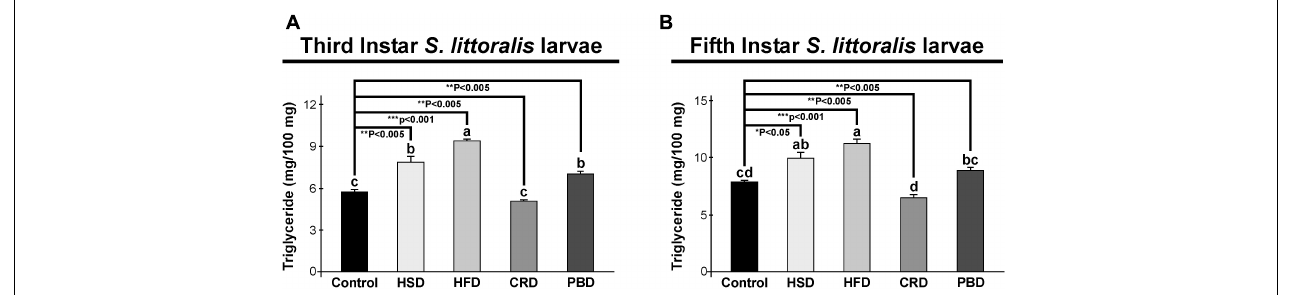
FIGURE 2 | Effects of different diet treatments on the triglyceride levels of Spodoptera littoralis . Triglyceride levels at third (A) and fifth instar (B) larval bodies are shown as mg in 100 mg body weight. Statistical significances in the entire sample set were determined by using one-way ANOVA, followed by a Tukey HSD test (groups associated with different letters are significantly different among each other, p < 0.05). A t -test was used for binomial comparisons (diet treatment vs control) (* p < 0.05, ** p < 0.005, *** p < 0.001 indicate the statistical differences between the particular diet and the control). Values are expressed as means ± standard error. Control, Regular artificial bean diet; HSD, High sugar diet; HFD, High fat diet; CRD, Calcium-rich diet; PBD, Plant-based diet.